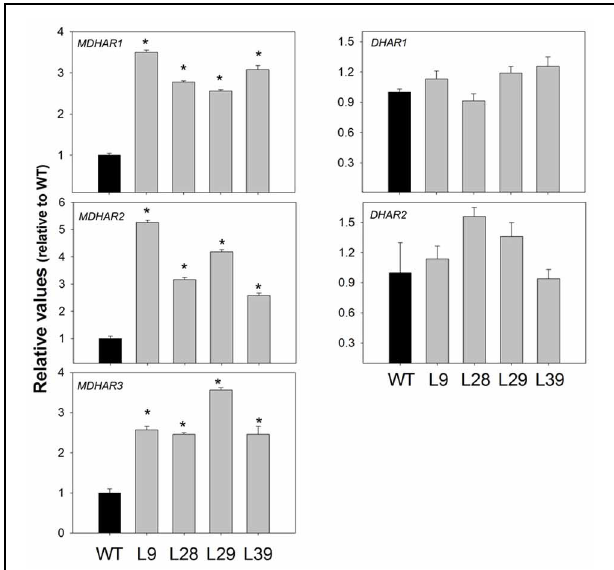
FIGURE 7 | Expression of MDHAR, and DHAR genes in red B33-PPi fruits. The abundance of MDHAR1 (acc. number Solyc09g009390 ), MDHAR2 (acc. number Solyc02g086710), MDHAR3 (acc. number Solyc08g081530), DHAR1 (acc. number Solyc05g054760), and DHAR2 (acc. number Solyc11g011250). mRNAs were measured by quantitative RT-PCR, respectively. An asterisk indicates the values that were determined by the t -test to be significantly different ( P < 0 . 05) from wild type.